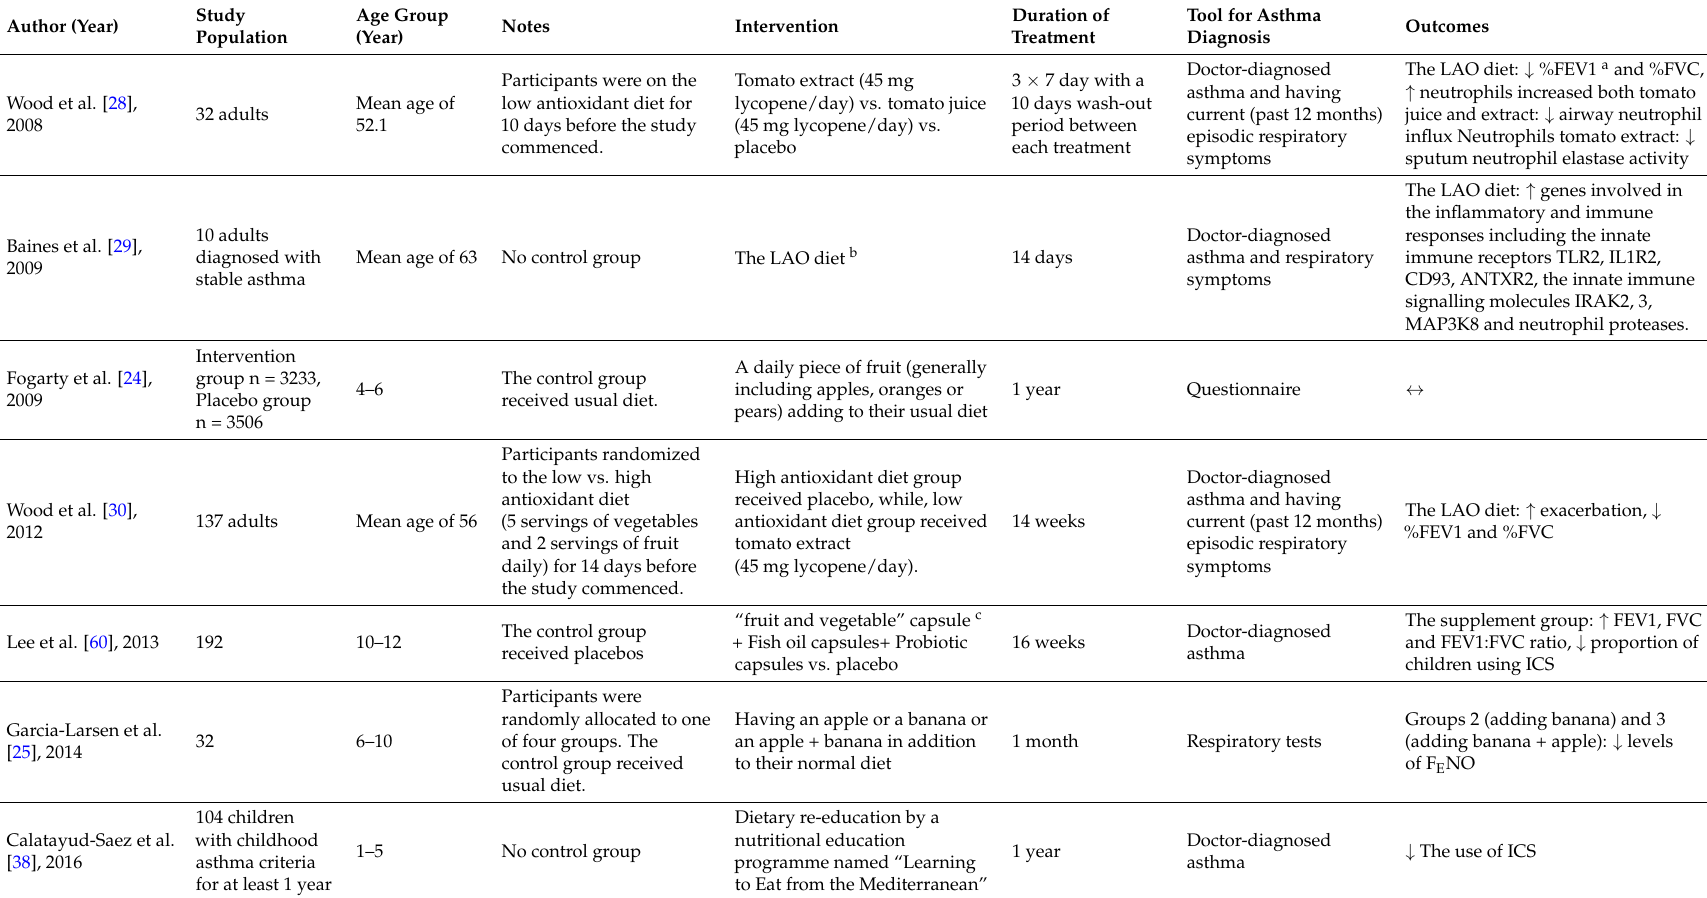
Table 4. Summary of experimental studies on the association between fruit and vegetable intakes and